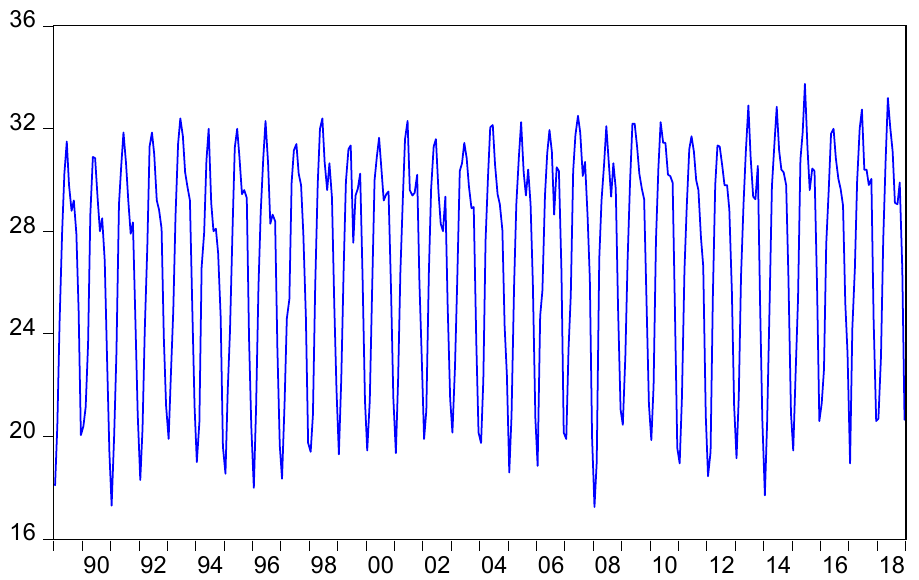
Figure 1. The plot of average monthly temperature data series of Karachi